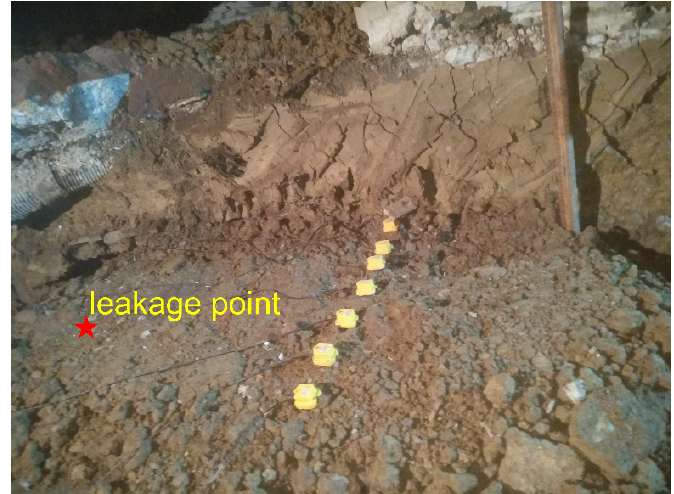
Figure 6. Ground surface vibration measurement using the sensor array at the distance of 1 m from the leak.